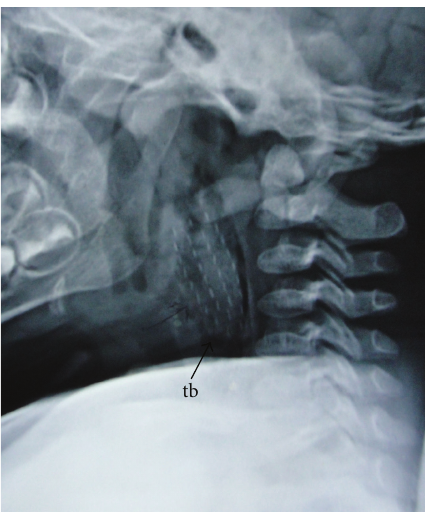
Figure 1: X-ray of the neck showing the head of the toothbrush (tb) with the bristles (dotted lines) in the retropharyngeal space extending from the level of C1 to C5 vertebrae.